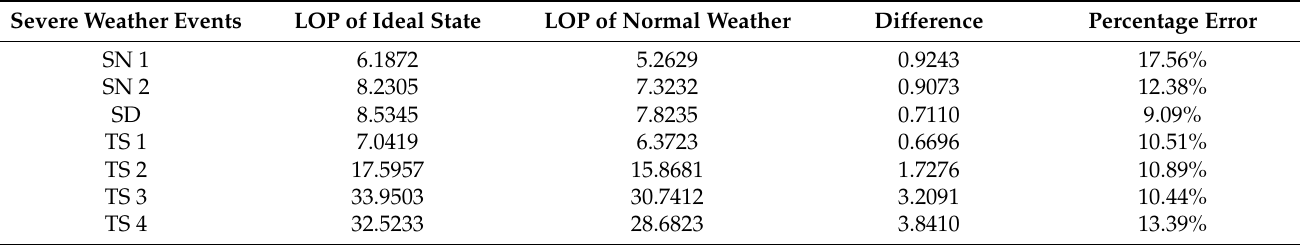
Table 2. Comparison of LOP in two